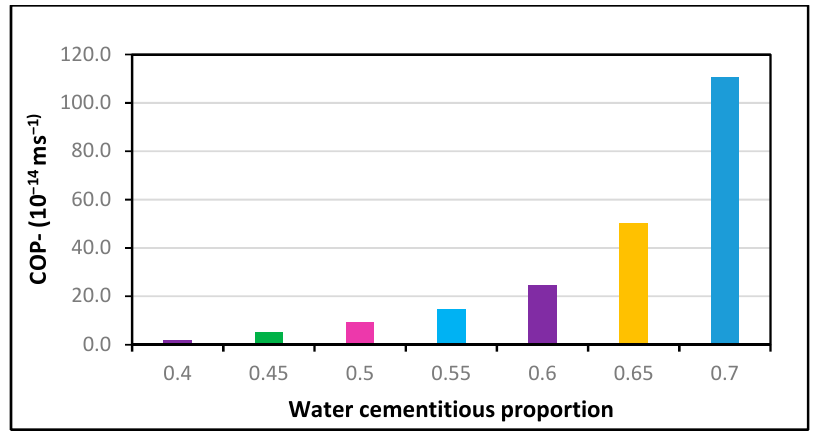
Figure 3. Relationship between the coefficient of permeability and the w/c proportion. For analysis, the experimental results provided by Zunino and Lopez [61] were used. RHA was purchased from various vendors with varying amorphous contents of d 50 , BET SSA, and SiO 2 . The experiment was performed at a cement replacement rate of 20% RHA and a w/c ratio of 0.5, and higher modification ratios were applied using the abovemen- tioned formulas. The findings show that RHA’s pozzolanic contribution changes with the average particle size, the grinding time, the w/c ratio, the SSA, and the cement substitution dosages of RHA, as displayed in Figures 4–8. Figure 4. Discrepancy trends of the pozzolanic impact with the particle diameter and w/c ratio.